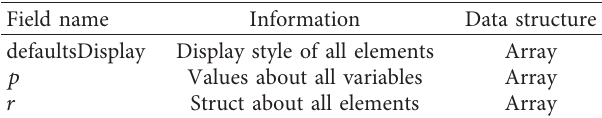
Figure 2: A resource named “translation of polygon.” Table 1: The content field in the JSON